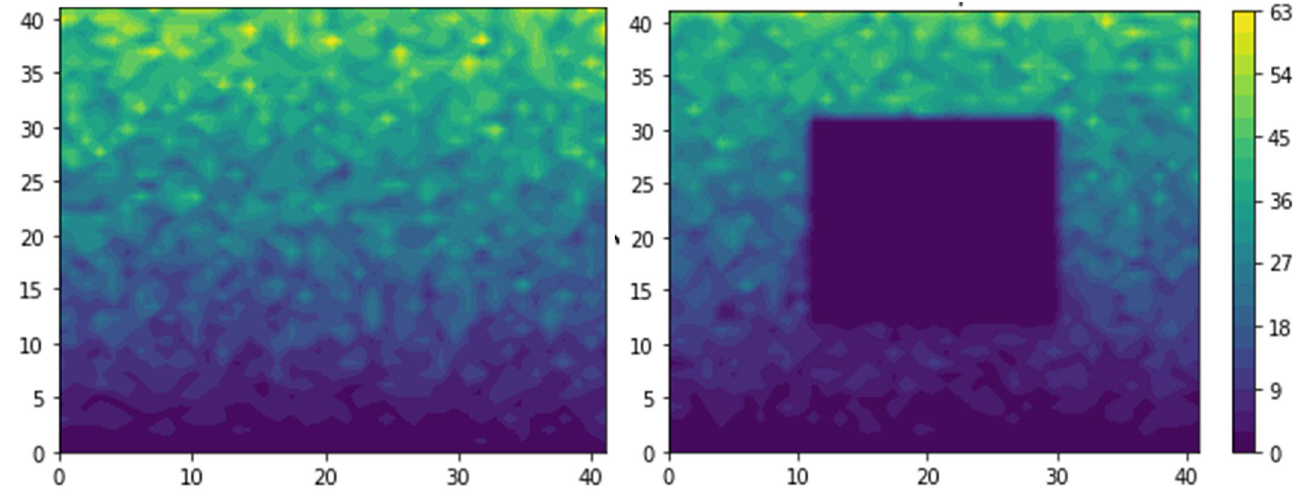
Figure 10. The plot of the instantaneous steady-state concentration profile for a neat polymeric membrane ( left ) and an MMM ( right ) with an impermeable filler (19 × 19 × 19) in an elementary unit (41 × 41 × 41). The x - y profile was obtained at the median z -direction.